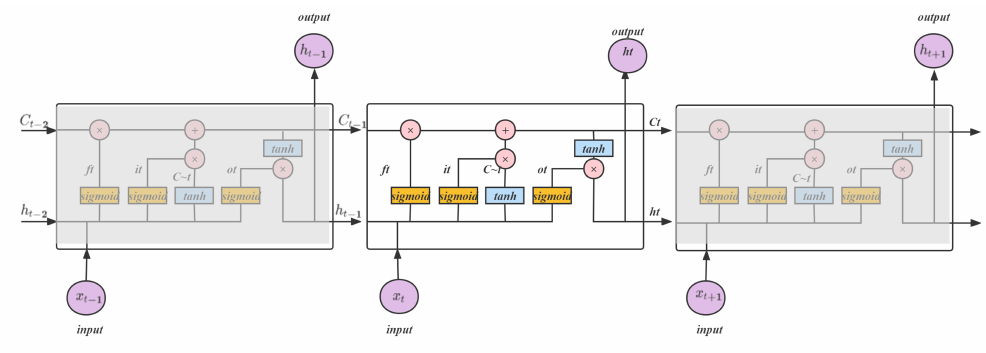
Figure 2. Schematic diagram of the state of the LSTM unit - basic unit model and the data output transfer between each neuron are used to finish the prediction